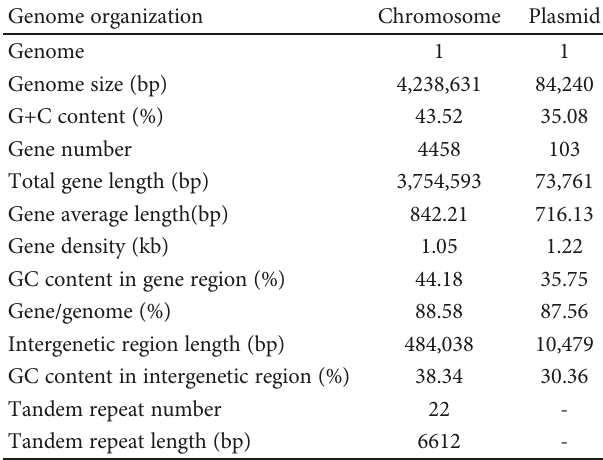
Table 1: Genome organization of B. subtilis strain